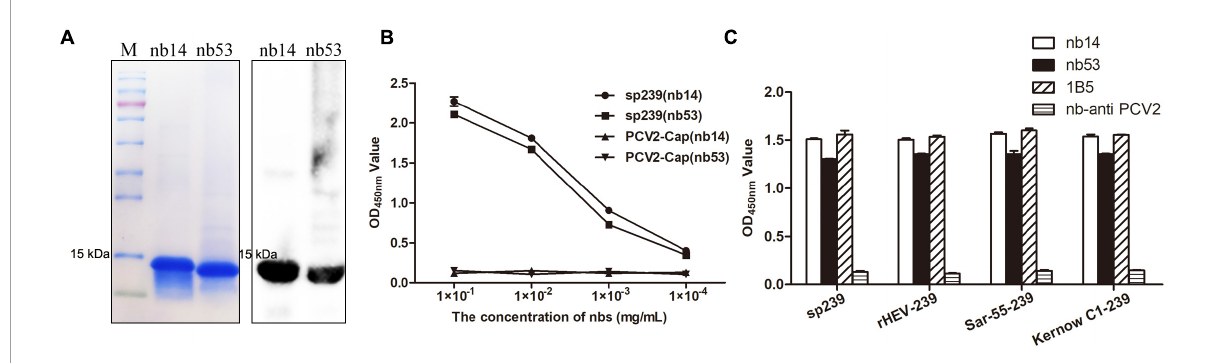
FIGURE2 Analysis of purified nanobodies. (A) His-tagged nb14 and nb53 with a predicted size of 15 kDa were detected by SDS-PAGE and Western blotting. (B) Detection of the binding activities of nb14 or nb53 to sp239 by iELISA. The PCV2-cap protein was used as a negative control. Data were processed with triplicate experiments and are presented as the means ± SDs. (C) The nb14 and nb53 interact with sp239, rHEV-239, Sar-55-239, and Kernow C1-239 protein by iELISA. The 1B5 and nb anti-PCV2 antibodies were used as positive and negative controls, respectively.